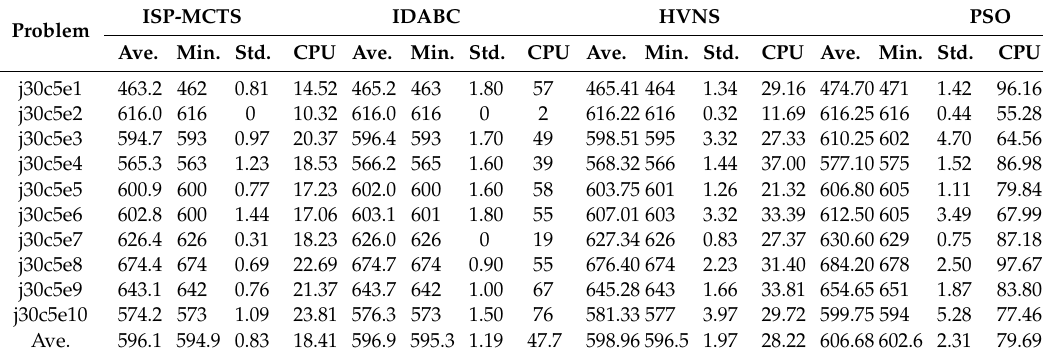
Table 7. Comparison results for the ten harder problems.